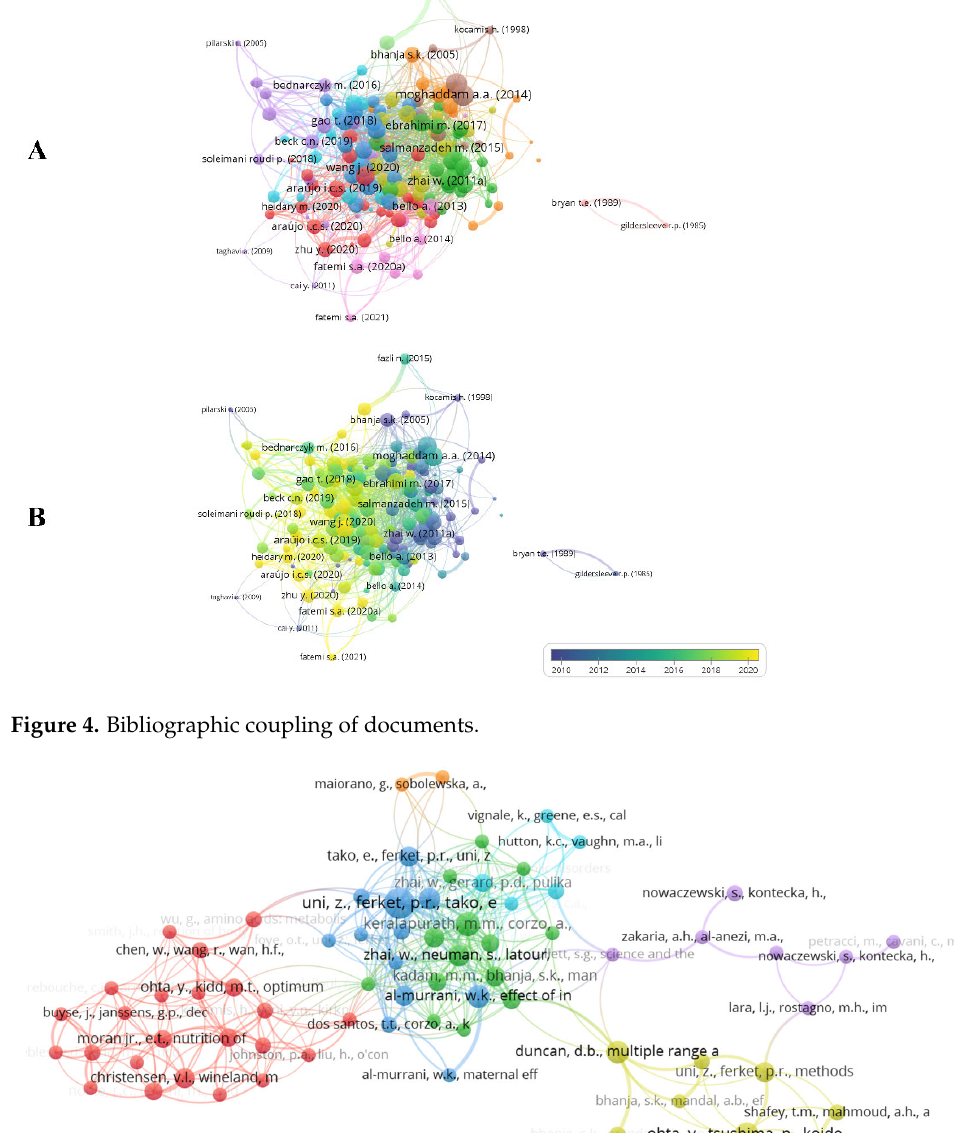
Figure 6. Authors network based on number of documents. A total of 914 authors were identi fi ed. By limiting the numbers to four citations and four documents per author, 28 authors were included in the citation network (Figure 7A).